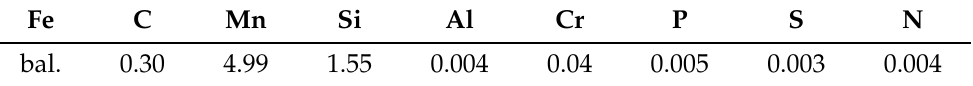
Table 1. Chemical composition (in wt.%) of the studied medium manganese